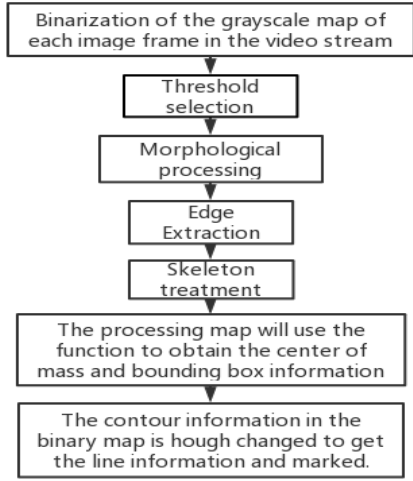
Figure 14. Image processing flow chart.